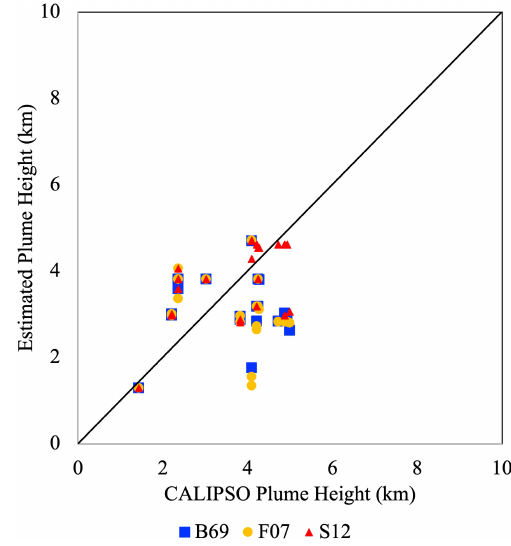
Figure 4. Comparisons of plume-top heights from three simula- tions, namely B69 (blue rectangle), F07 (orange dot), and S12 (red triangle), against aerosol height observations from the CALIPSO for West Coast fires.